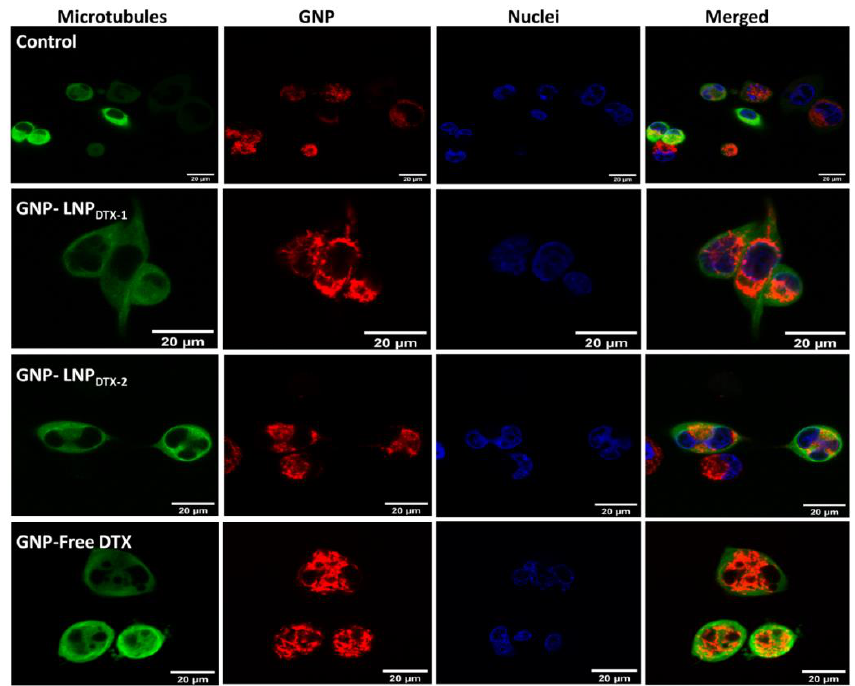
Figure 3. Visualization of intracellular GNP distribution in MIA PaCa-2 cells using confocal imaging. Control untreated cells (1st row), cells treated with LNP DTX-1 (2nd row), cells treated with LNP DTX-2 (3rd row), and cells treated with free DTX (4th row). Microtubules in green (1st column), GNPs in red (2nd column), nuclei in blue (3rd column), and all three merged (4th column). Scale bar: 20 µm.